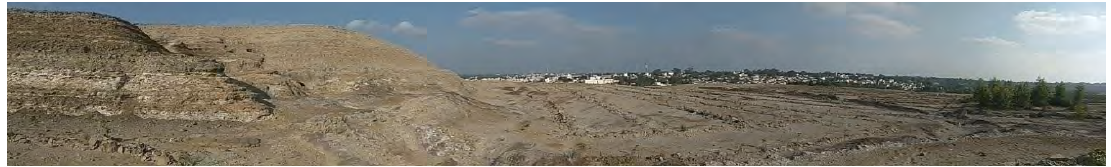
Figure 14. Panoramicview showing dump and